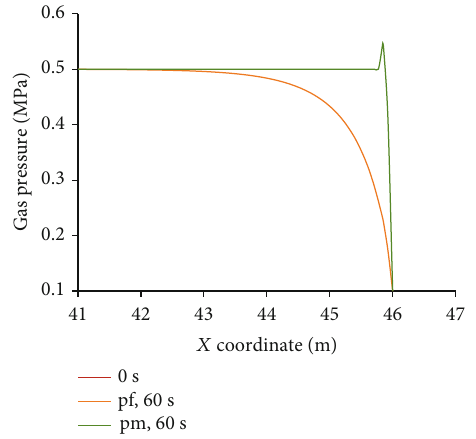
Figure 4: Distribution law of gas pressure in coal seam